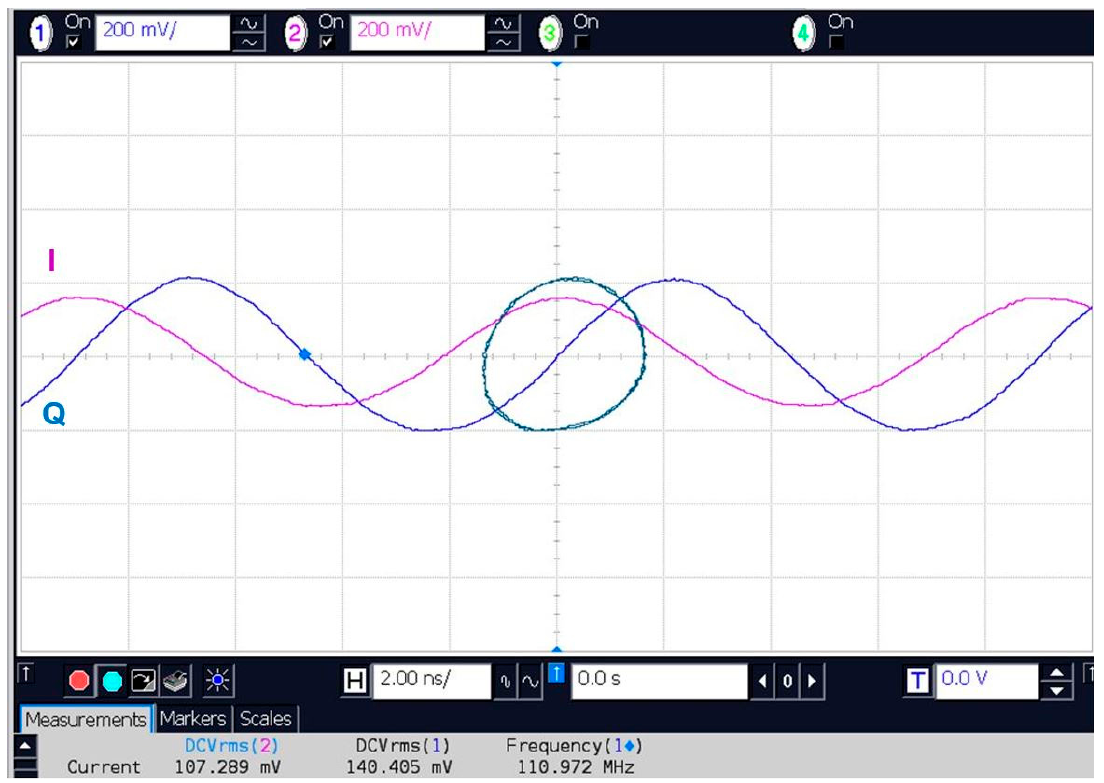
Figure 46. E-band multi-port receiver front-end under test with VNA source.